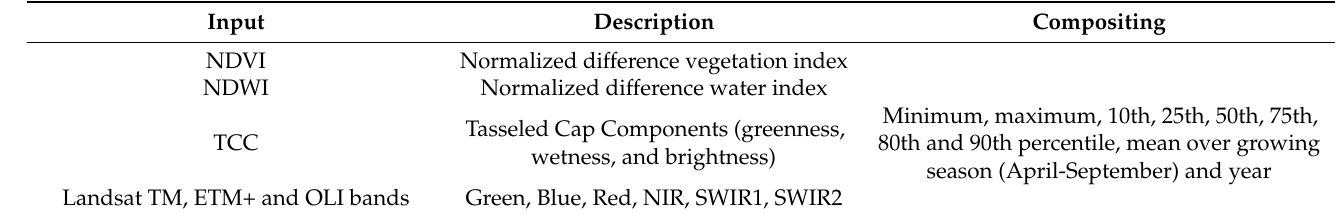
Table 1. Input variables used in LU/LC